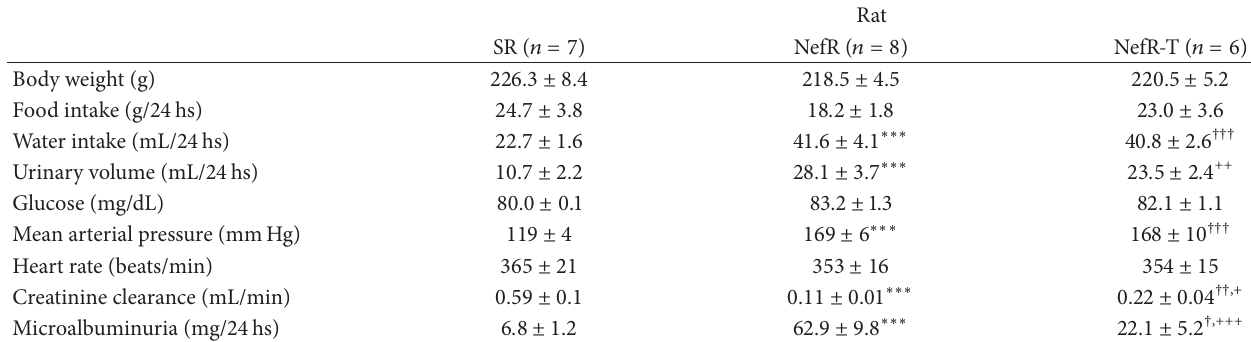
Table 1: Clinical characteristics of